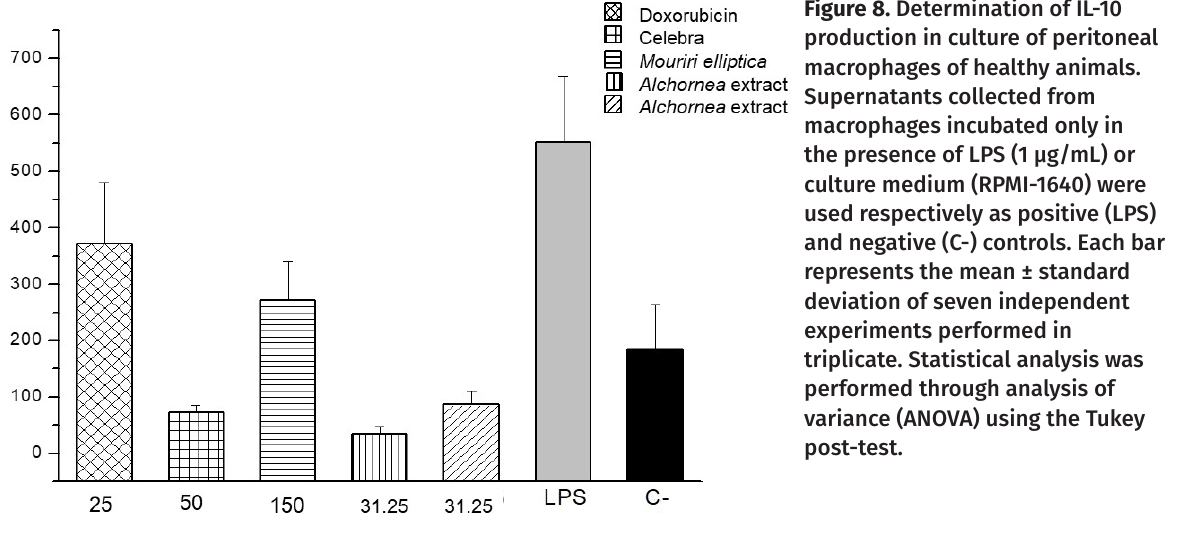
Figure 8. Determination of IL-10 production in culture of peritoneal macrophages of healthy animals. Supernatants collected from macrophages incubated only in the presence of LPS (1 μg/mL) or culture medium (RPMI-1640) were used respectively as positive (LPS) and negative (C-) controls. Each bar represents the mean ± standard deviation of seven independent experiments performed in triplicate. Statistical analysis was performed through analysis of variance (ANOVA) using the Tukey